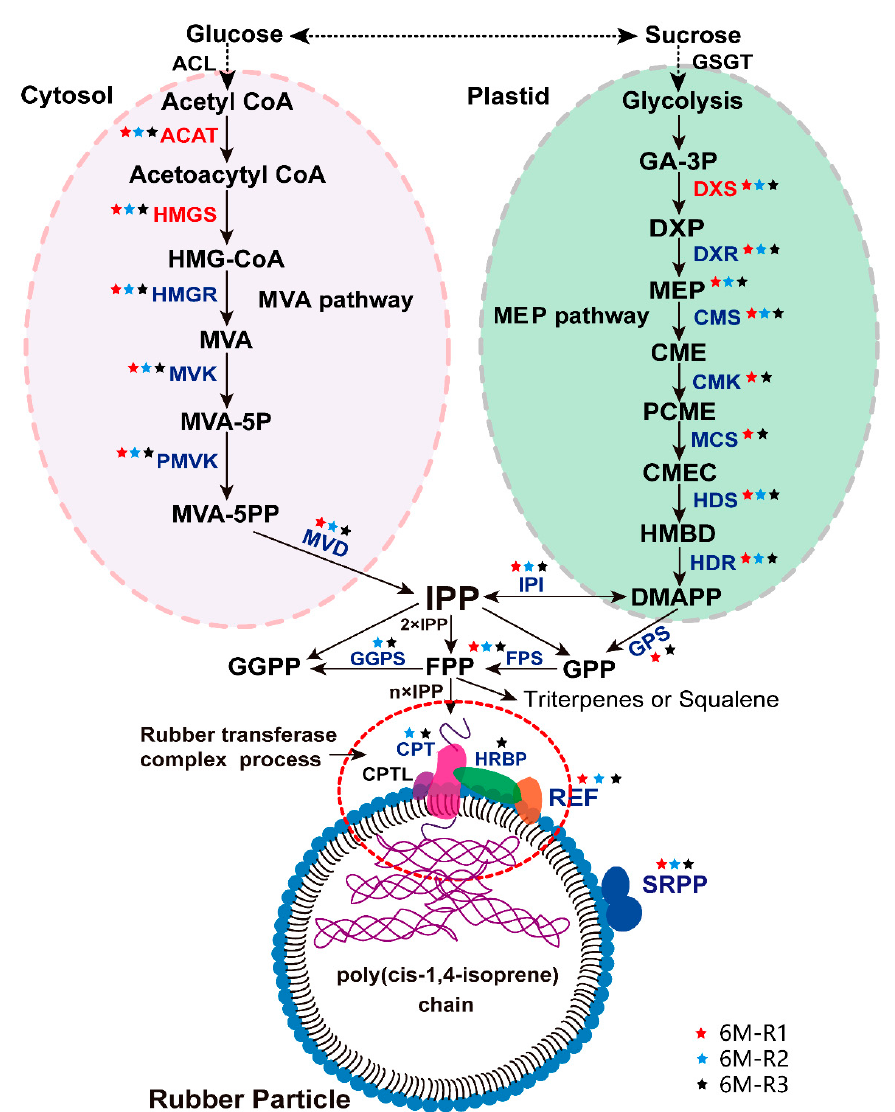
Figure 7. Schematic diagram of natural rubber biosynthesis (NRB) ‐ related proteins in the 6M TKS roots. A schematic diagram of the identified proteins involved in the mevalonate acid (MVA, left) and methylerythritol phosphate (MEP, right) pathways of NRB is highlighted. In this schematic diagram, the identified proteins involved in NRB from the 6M TKS roots were marked with different color. The name of proteins identified from both 2 ‐ DE and shotgun methods was marked in red color. The proteins only determined by shotgun analysis are marked in blue color. The proteins identified from the first (6M-1), second (6M-2) and third (6M-3) shotgun experiments are marked with red, blue and black stars,